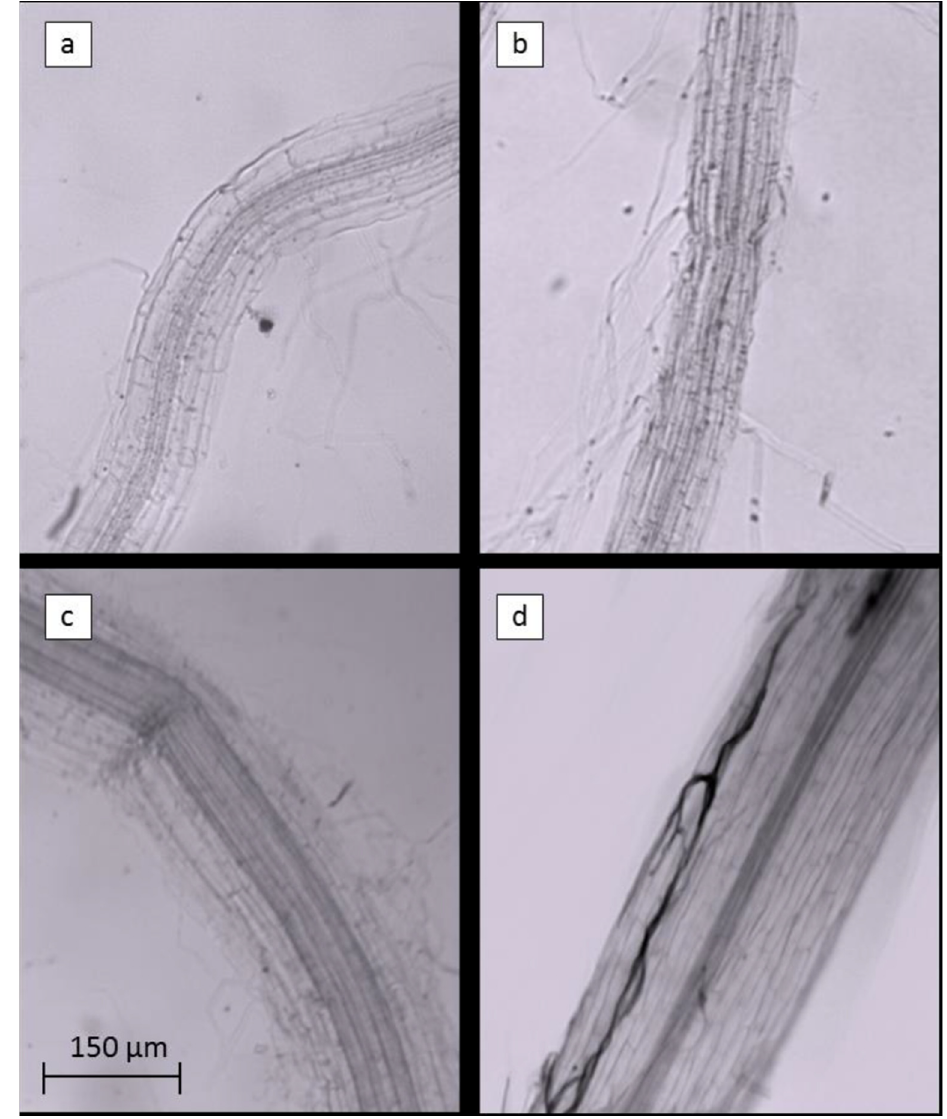
Figure 6. Portions of Agrostis stoloniferous L. roots bleached with KOH and treated with Clozaril black E to evidence the Arbuscular Mycorrhizae symbiosis within the root tissues. Roots of control ( a ), EM ‐ 1 ( b ), ExpA ( c ) and ExpB ( d ) are shown in order.